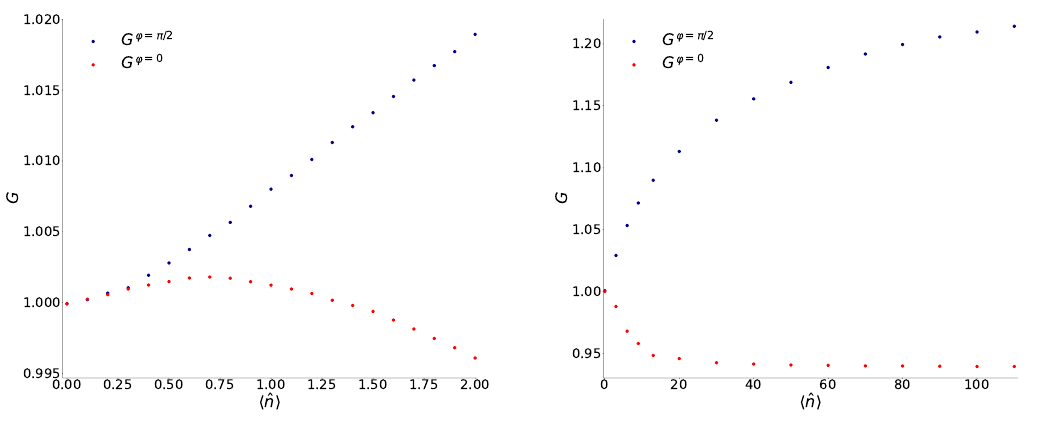
Figure 7. The “Gaussianity” measure (26) as a function of (cid:104) ˆ n (cid:105) . Numeric calculations were performed with 10,000